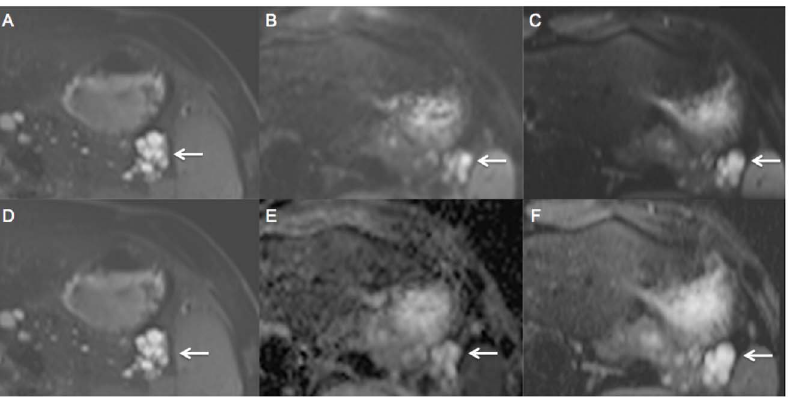
Figure 3. A 27-year old patient with serous cystadenoma in the pancreatic tail (arrow). T2 HASTE (A, D), c-EPI DWI (B, E) and z-EPI DWI (C, F) of the pancreas were acquired. z-EPI DWI (C) and zoomed ADC map (F) demonstrate a better delineation of the pancreas and the serous cystadenoma compared to c-EPI DWI (B) and conventional ADC map (E).